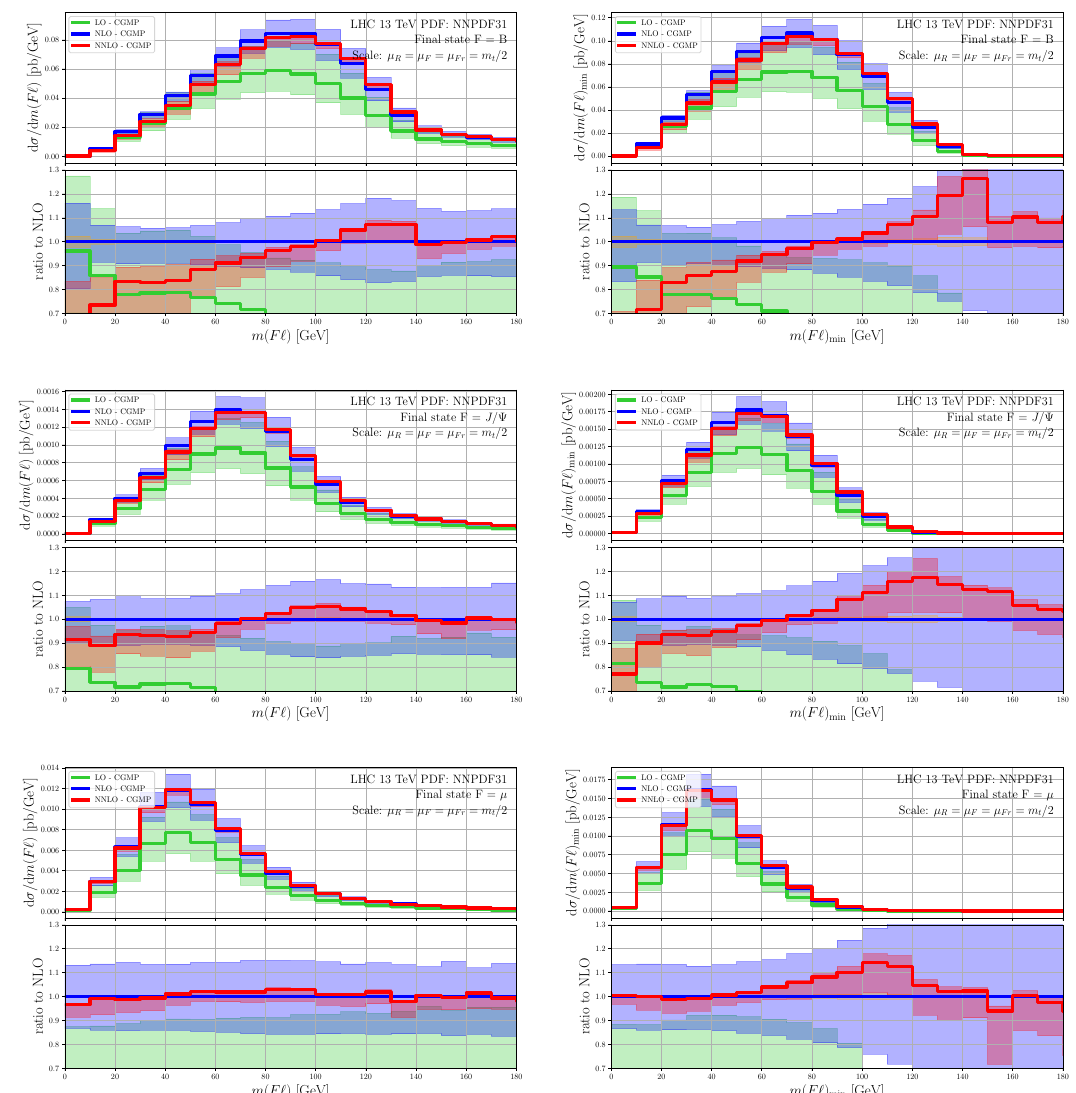
Figure 10 . As in figure 9 but for m ( F‘ − ) (left column) and m ( F‘ ) min (right column).